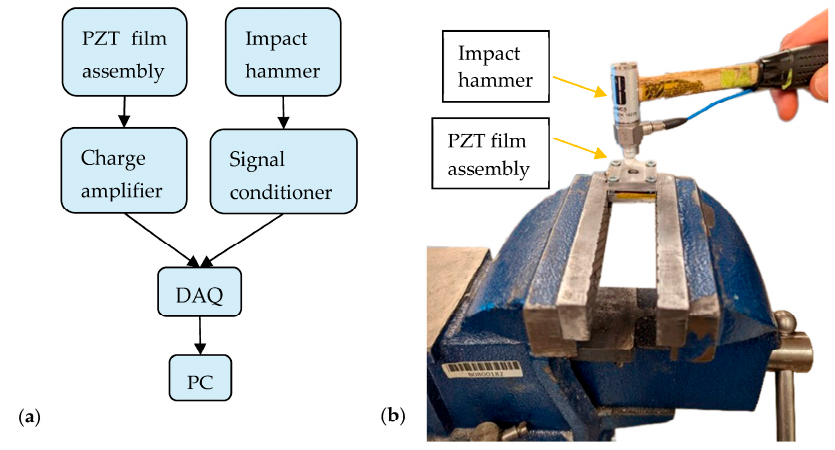
Figure 14. ( a ) PZT force sensor schematic; ( b ) photo of the testing process.